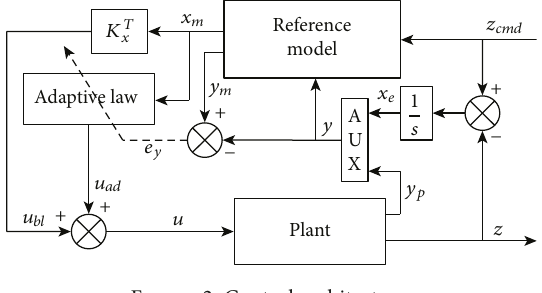
Figure 2: Control architecture.